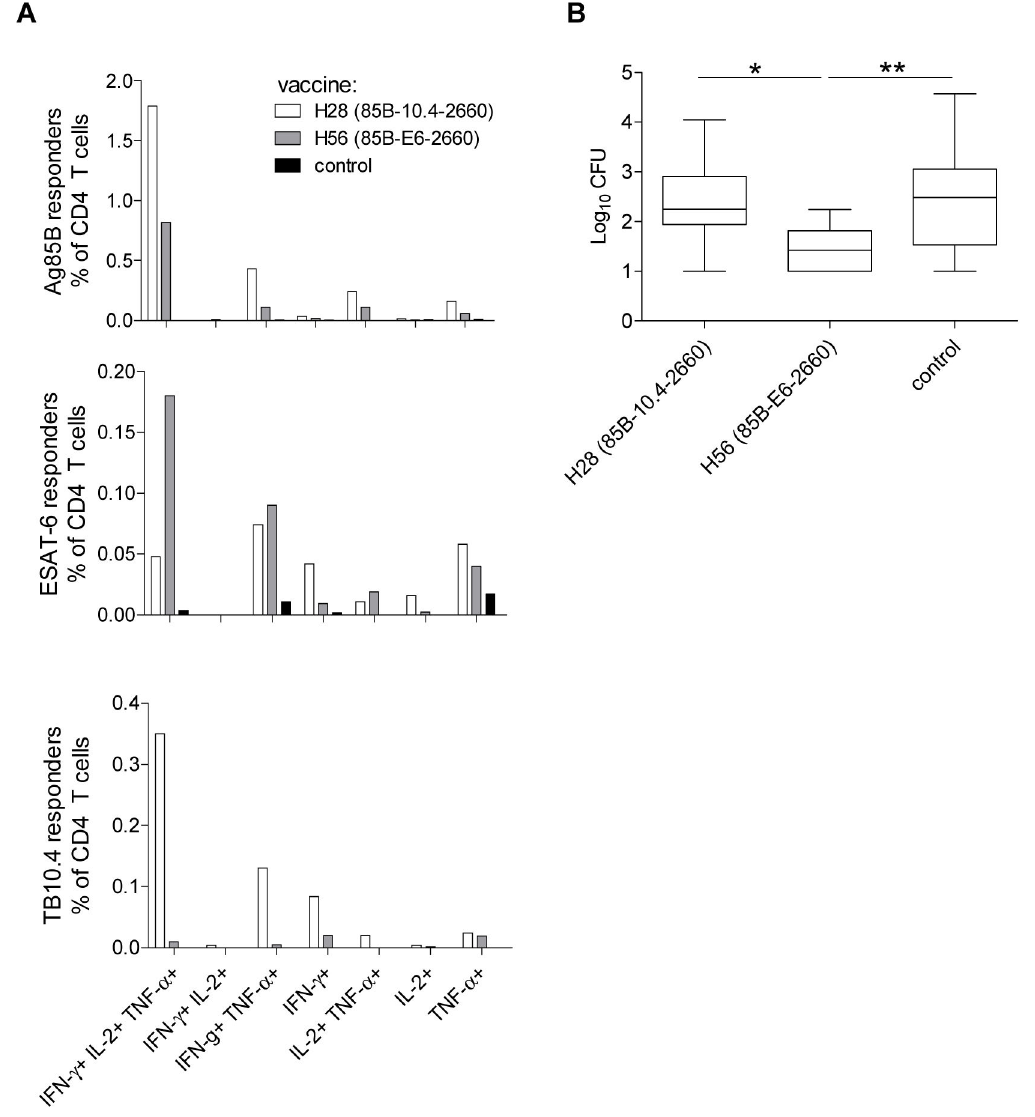
Figure 4. H56 but not H28 vaccination provides post-exposure protection against relapse. CB6F1 mice (n=12-18) were infected by the aerosol route and at week 6 post-infection (p.i.) treated with antibiotics given in the drinking water ad libitum . Mice were vaccinated three times s.c. with CAF01 alone, H28/CAF01 or H56/CAF01 at week 10, 13 and 16 p.i. (A) PBMCs (pooled from 16 mice) were obtained by submandibular bleeding one week after the last vaccination and the frequency and quality of antigen specific CD4 T cell responses were determined by six hour culturing of lung lymphocytes with Ag85B, TB10.4 or ESAT-6 from adjuvant control (black bars), H56/CAF01 (grey bars) and H28/CAF01 (white bars) animals. After culturing, cells were stained for CD4, IFN-γ, IL-2 and TNF-α, analyzed by ICS and subpopulations were divided according to their cytokine profile. Similar patterns of immune responses have been observed in two other experiments. (B) Protection was assessed at week 44 p.i. by culturing lung homogenates (n=12 for test groups and n=18 for control group) for 2-3 weeks at 37°C and enumerating the number of bacteria (expressed as log ). Data displayed are box and whiskers showing median values and minimum and maximum CFU levels. Values 10 marked with an asterisk are significantly different from naïve control animals as assessed by non-parametric Kruskall-Wallis multiple-comparison test (**, p <0.01, *, p <0.05). Data is representative of two independent experiments, although individual H28 and H56 vaccine evaluations have been done in several other experiments as illustrated in Figure 6. doi: